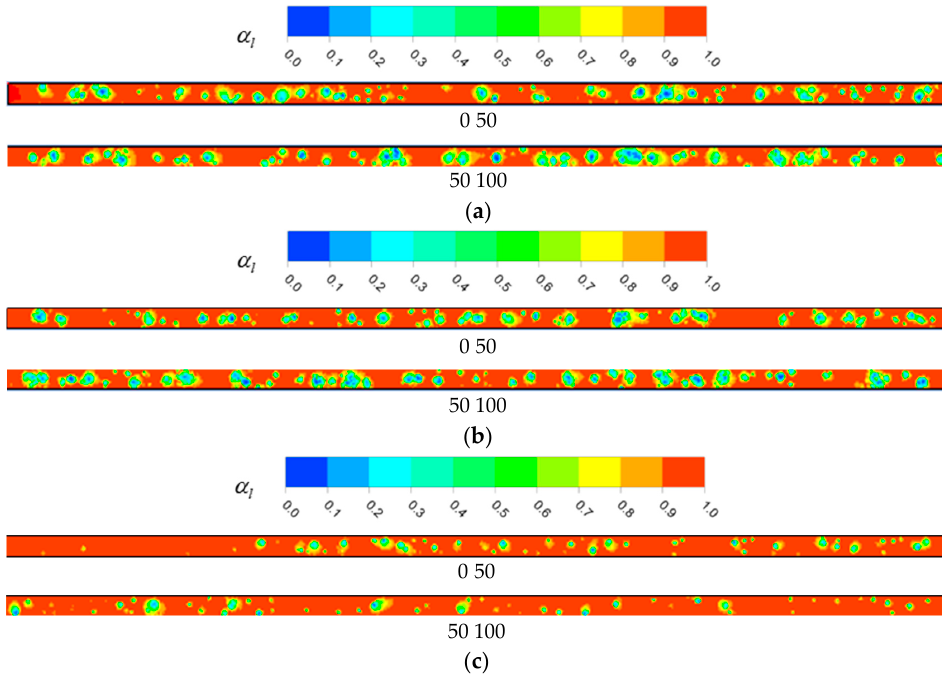
Figure 5. Volume fraction distribution of R744 liquid phase at different heat fluxes: ( a ) T sat = 253 K, G = 50 kg/m 2 s, q = 10 kW, X = 0.28; ( b ) T sat = 253 K, G = 50 kg/m 2 s, q = 20 kW, X = 0.56; ( c ) T sat = 253 K, G = 50 kg/m 2 s, q = 30 kW, X = 0.84.